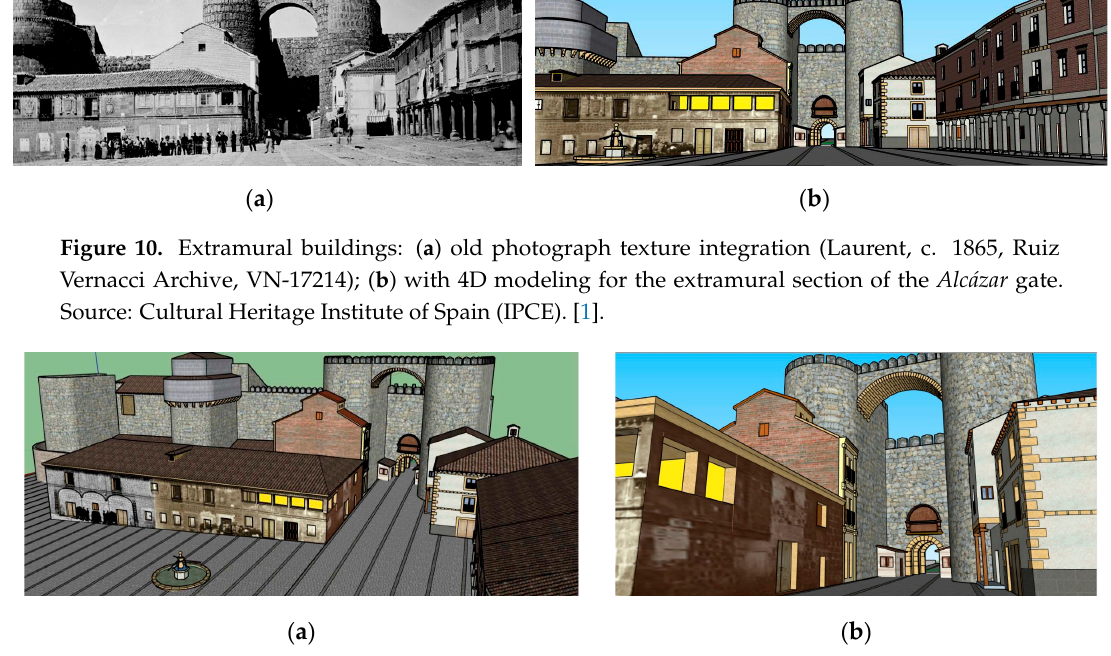
Figure 11. Extramural buildings; different views of the 4D modeling of the Alcázar gate surroundings, mid-19 th century: ( a ) overview of the Alhóndiga and the wall; ( b ) detailed view of the gate [1].